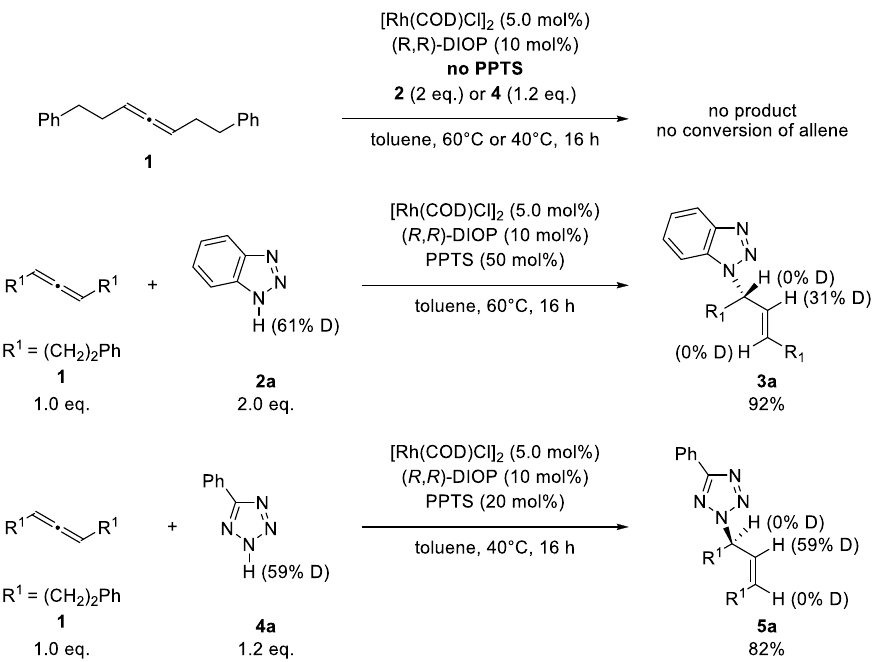
Figure 5. Scope of the addition of 5-phenyl-2H-tetrazole to different racemic allenes. Reactions were performed at 0.25 mmol scale. Cumulative yield for all isolated isomers. E/Z -selectivities deter- mined by 1 H-NMR. Enantioselectivities were determined by HPLC analysis using a chiral stationary phase. Unless specified, ee -values refer to main-stereoisomer of the main-regioisomer. Unless spec- ified full N 2 -selectivity was